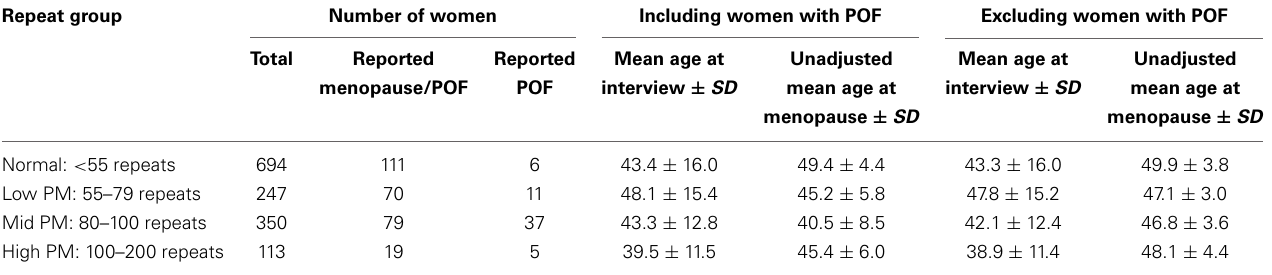
Table 1 | Unadjusted mean age at menopause including and excluding women with POF. Repeat group Number of women Including women with POF Excluding women with POF Total Reported Reported Mean age at Unadjusted Mean age